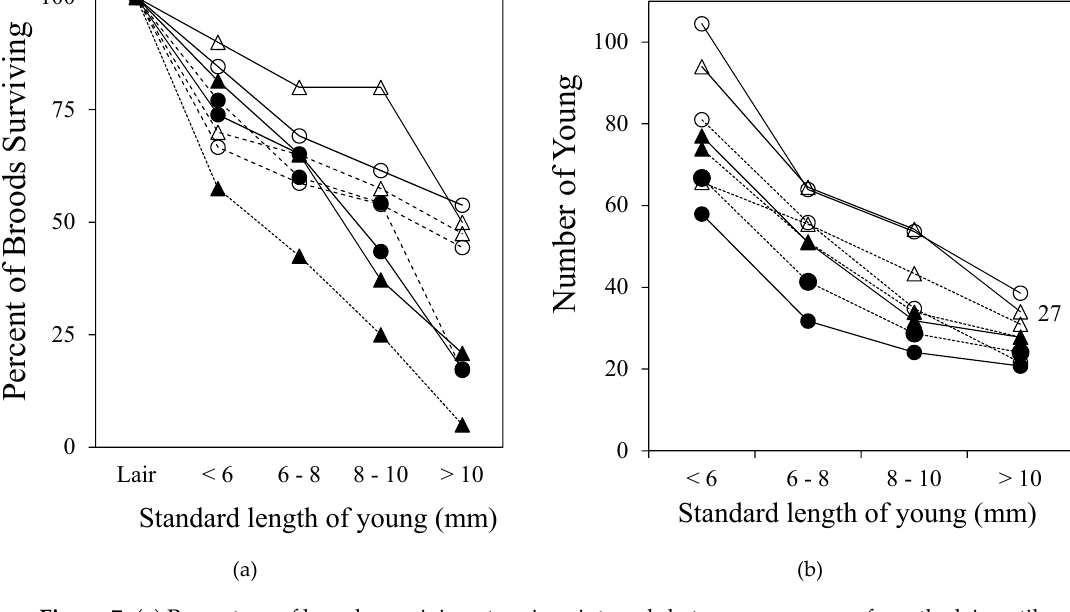
Figure 7. ( a ) Percentage of broods surviving at various intervals between emergence from the lair until independence from parental care after the young reach 10 mm SL. ( b ) Number of young in broods at these same intervals for each site. Although there were site differences in brood size initially, all site-years converged on an average of 27 fry at independence. Solid symbols, pool habitat; open symbols, stream habitat. Circles, Río Cabuyo; triangles, Quebrada Amores. Solid lines, 1990; dashed lines, 1991. Data from [9 ].